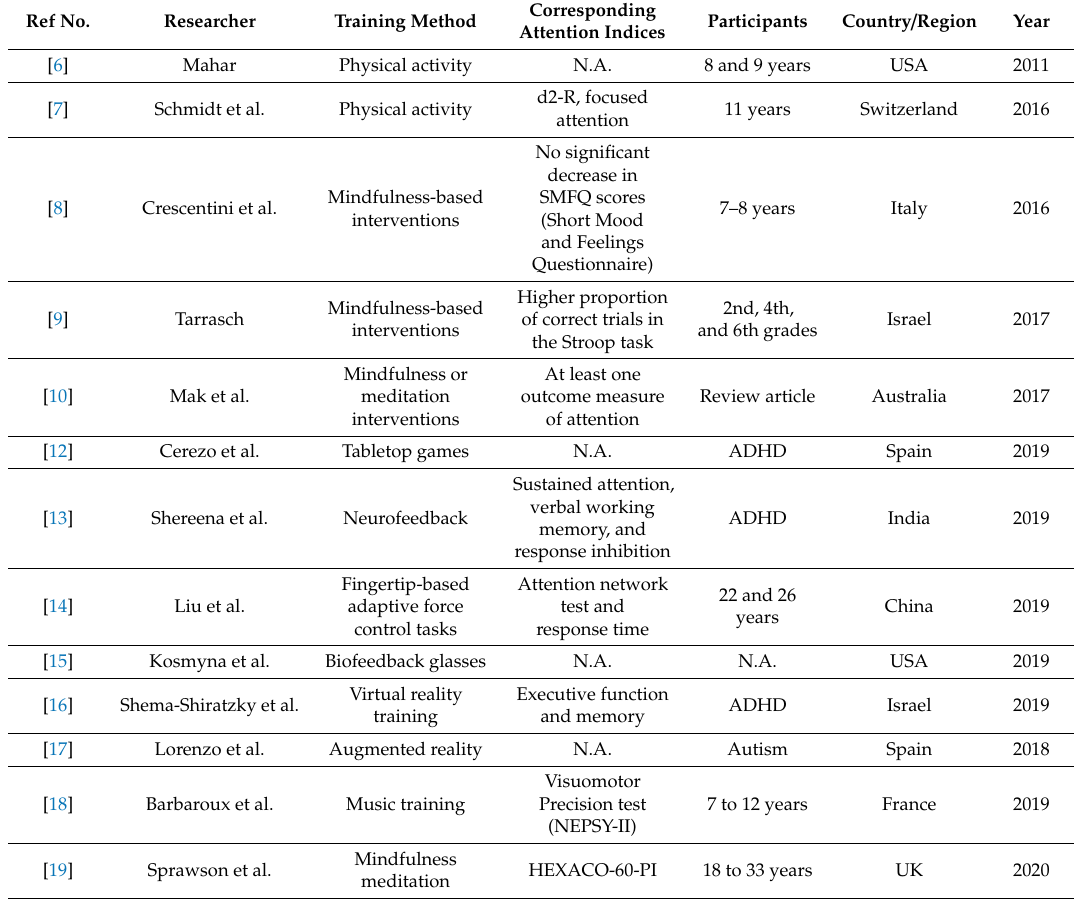
Table 1. Summary of related